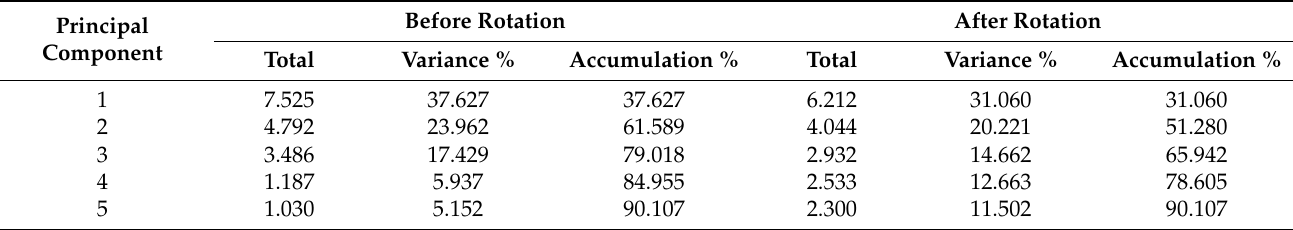
Table A4. Characteristic Root and Cumulative contribution rate of correlation Matrix.